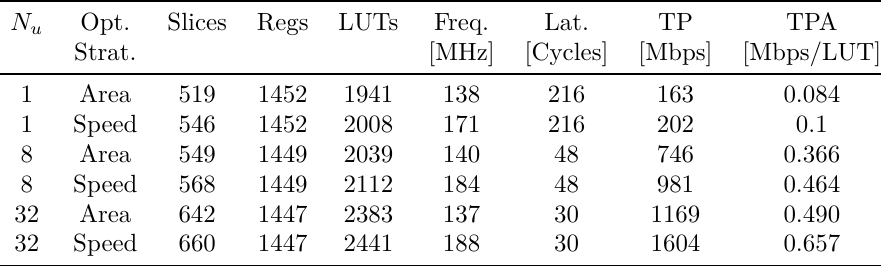
Figure 2: Architecture of Spook[128,512,su] (unprotected, inverse-free variant). Table 9: Artix-7 implementations results (post